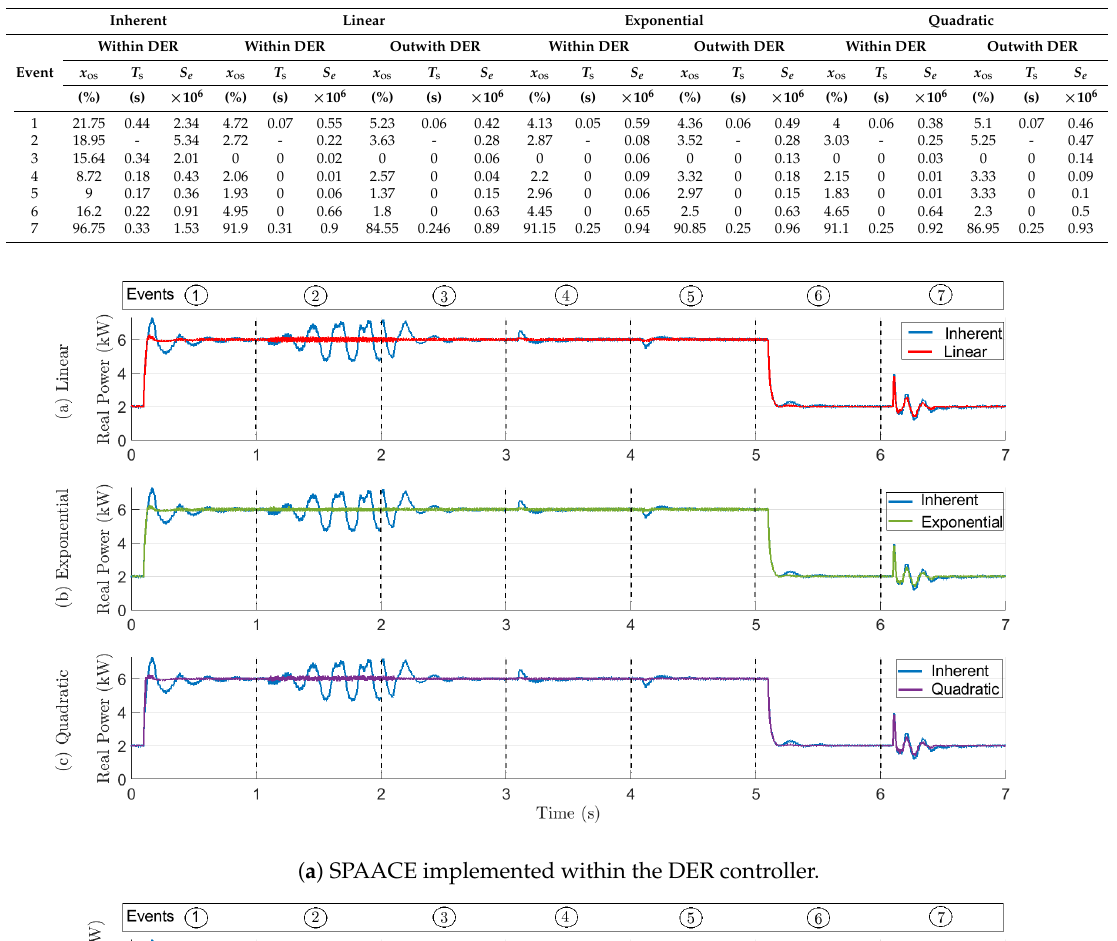
Table 4. Dynamic response performance indicators for the seven events under the grid-connected mode for operation.